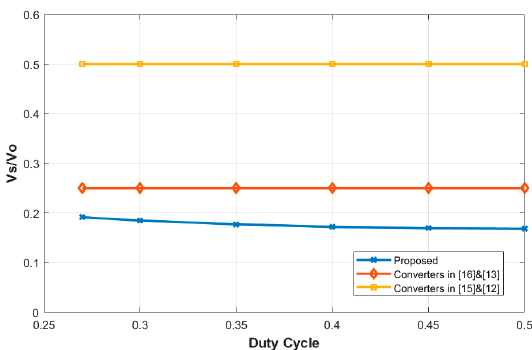
Figure 9. Switch voltage comparison for the proposed converter against others.